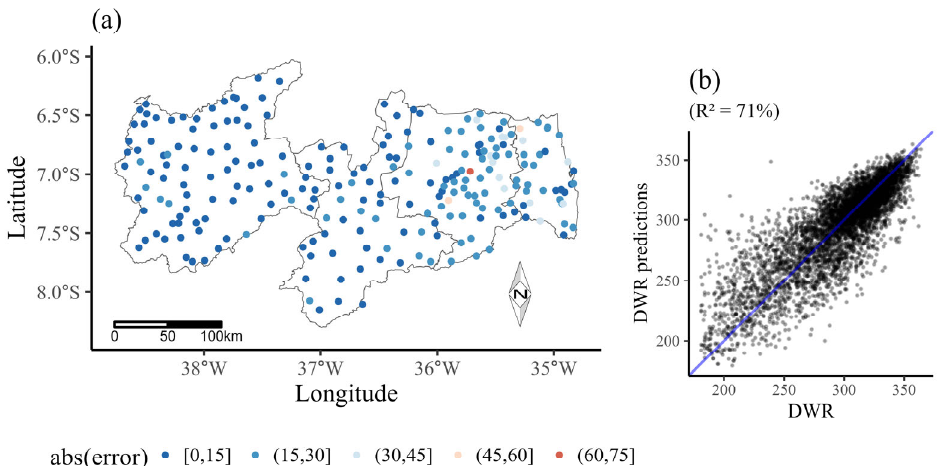
Figure 6. Leave-one-out cross-validation results for the annual number of days without rain (DWR) for the State of Paraíba. Figure ( a ) is the mean absolute error (abs(error)) at each station, and Figure ( b ) represents the relationship between the observed and predicted DWR data.